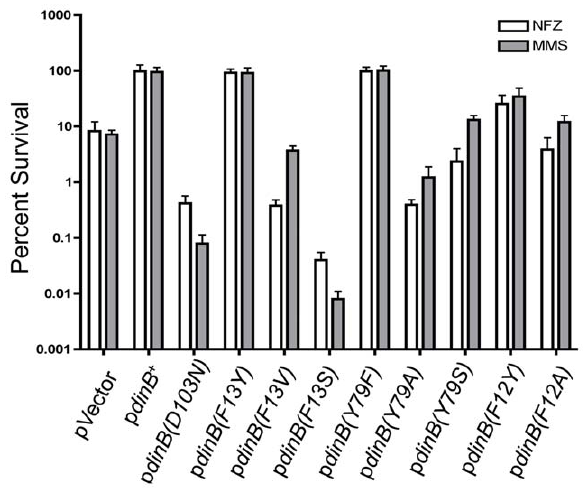
Figure 3. MMS or NFZ survival phenotypes of strains with catalytic or TLS deficient dinB chromosomal alleles. Cells carrying a single chromosomal copy of the catalytic deficient dinB(D103N) , the TLS deficient dinB(F13V) , and other dinB alleles were assayed for survival as indicated in material and methods with MMS (7.5 mM) or NFZ (0.008 mM). Error bars represent the standard deviation of the mean from at least 3 independent experiments.